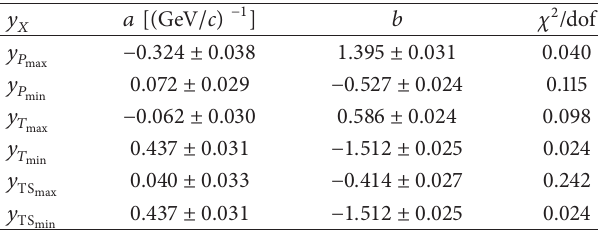
Table 2: Values of 𝑎 and 𝑏 in equations 𝑦 𝑋 = 𝑎𝑝 𝑇 +𝑏 . The unit of 𝑝 𝑇 is GeV/ c